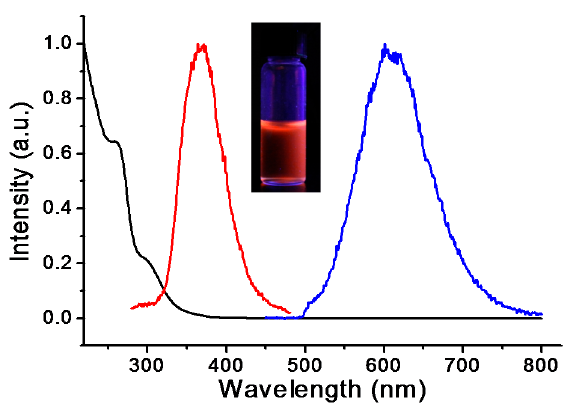
Figure 2. Absorption, excitation, and emission spectra of luminescent Cu(I)-GSH complex. ( λ abs = 255 and 300 nm; λ ex,max = 370 nm, λ em,max = 615 nm). Inset: Luminescent Cu(I)-GSH complex under ultraviolet with excitation wavelength of 365 nm. The fluorescence of Cu(I)-GSH complex was conducted in aqueous solution with pH of ~4.